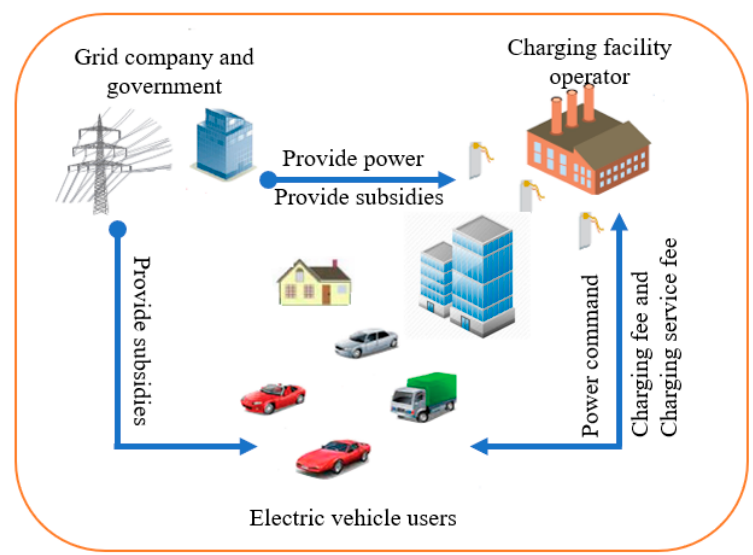
Figure 7. Diagram of the electric vehicle charging market. Table 3. Time-of-use price for charging piles.